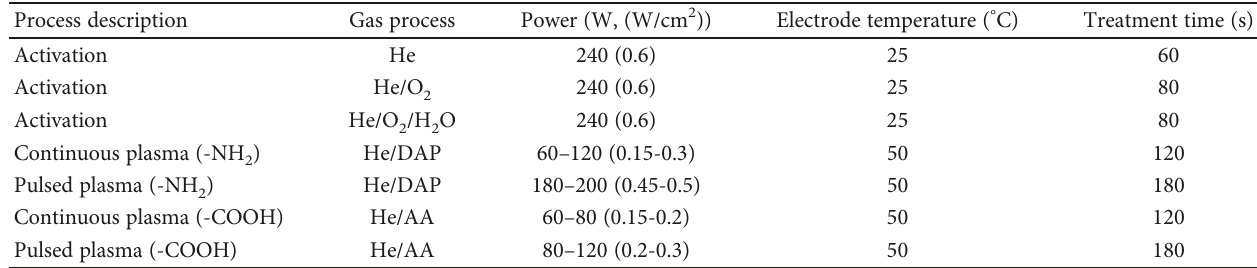
Table 1: Plasma process parameters for continuous and pulsed techniques.